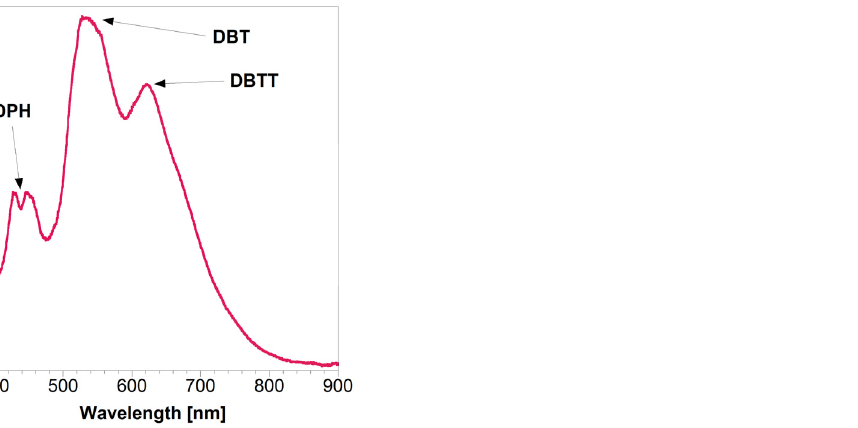
Figure 3. PL emission spectra of the DCA-DPH:DBT:DBTT films without any additives with differ- ent times of UV light irradiation (from 0 to 3600 s). It is possible to notice an evident quenching in the overall fluorescence intensity with increasing light exposure times, even though some differences can be highlighted. Specif- ically, a sharp emission decrease was observed for the peaks associated with DBT and DBTT (in the 475–585 nm and 585–750 nm ranges, respectively (Figure 2)) in the host– guest system, whereas a slower and less pronounced reduction in the PL intensity was